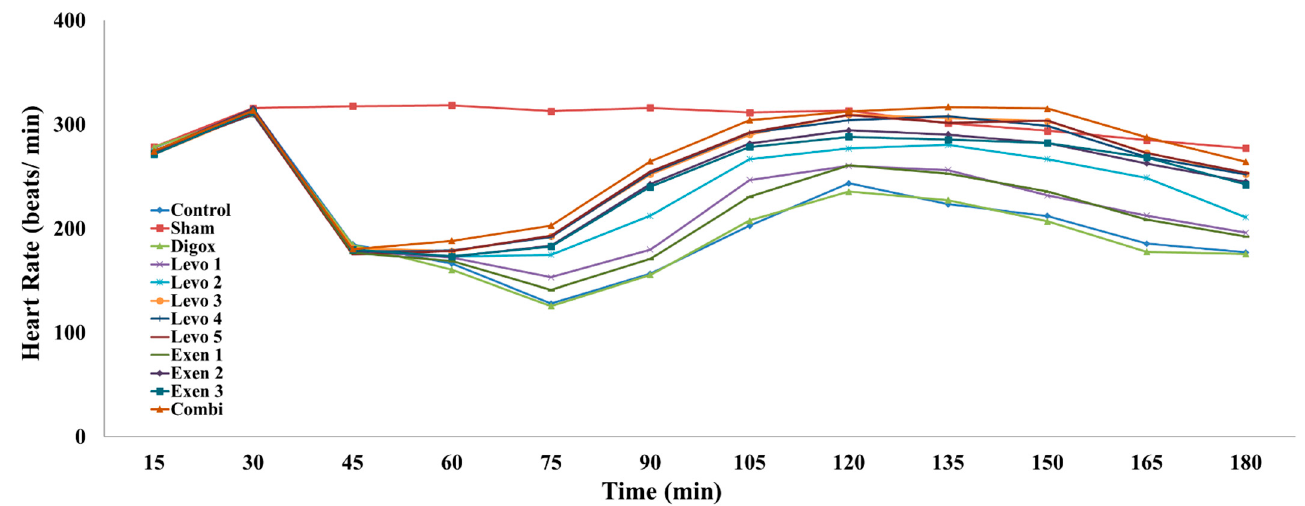
Figure 6. Changes in heart rate across groups over